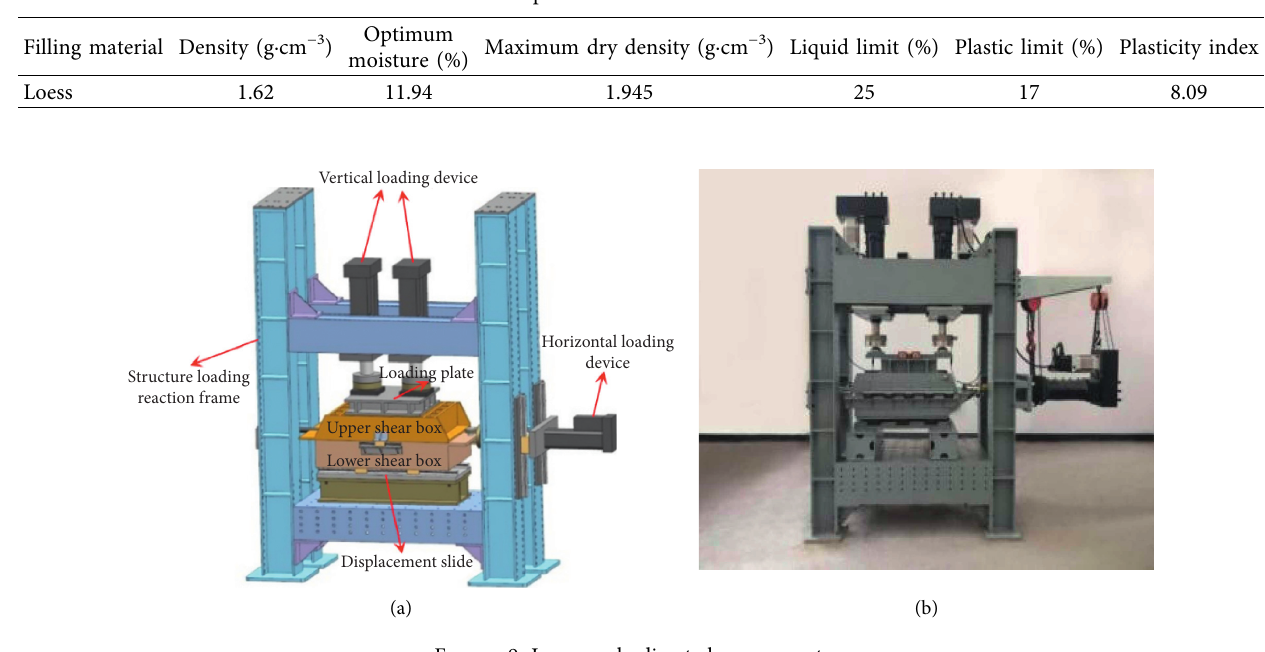
Table 5: Basic performance indicators of the test soil.